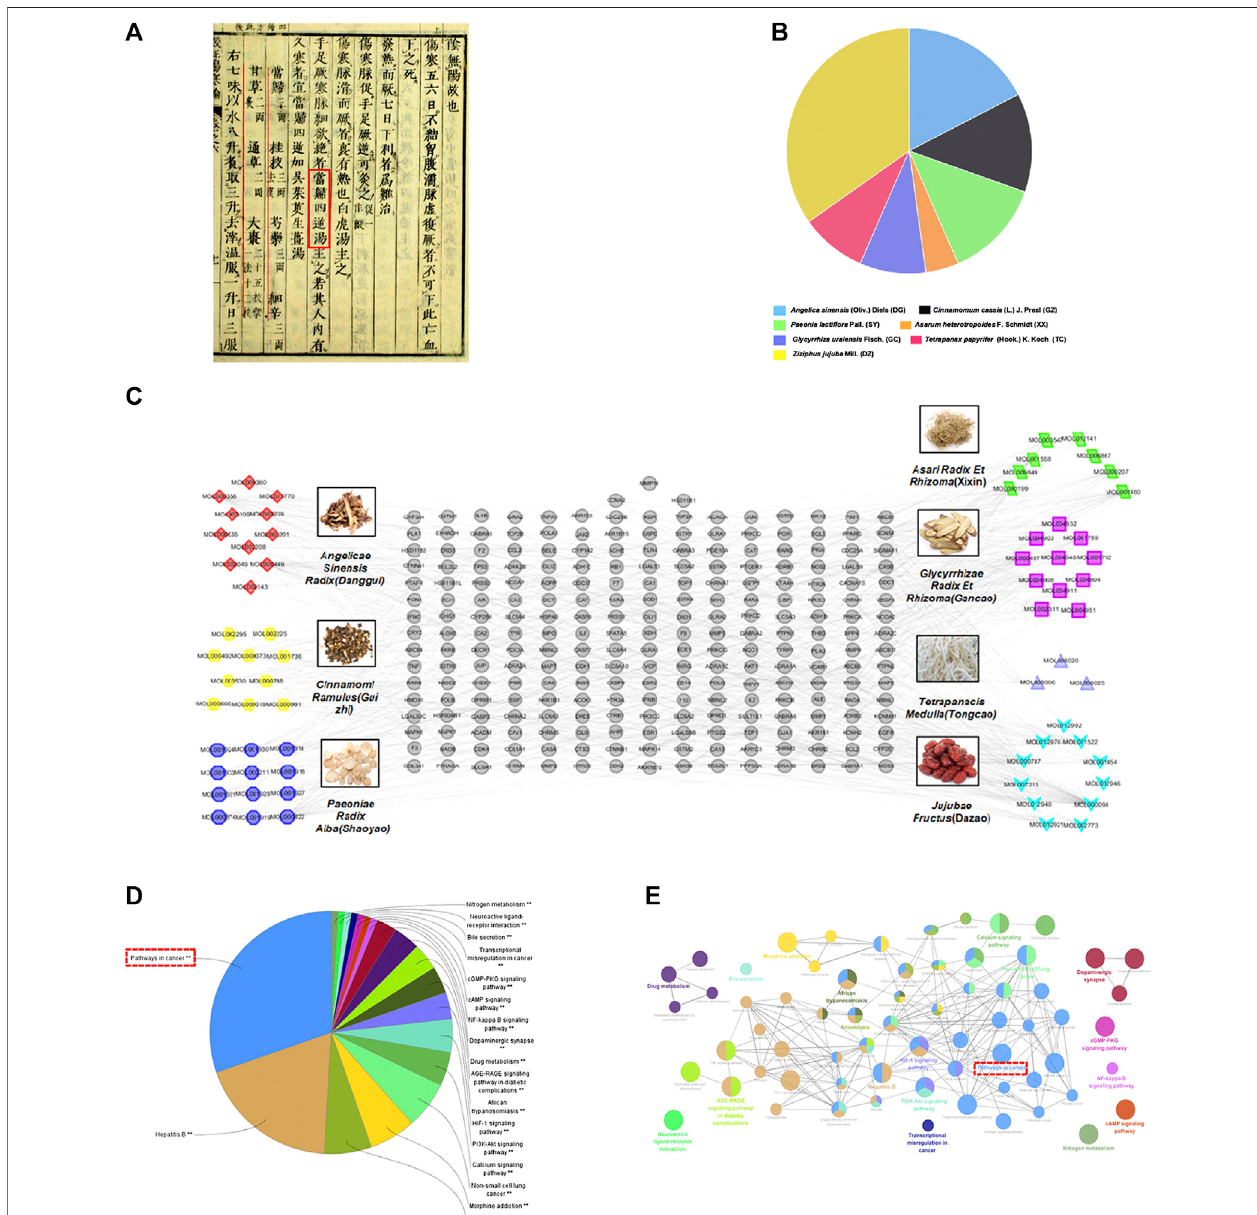
FIGURE1| ConstructionoftheDSDcandidateactiveingredient-putativetargetnetworkandenrichmentanalysis. (A) DangguiSiniDecoction(DSD)obtainedfrom theTreatiseonFebrileDiseases(Han Dynastyinancient China). (B) Thequalitymatchingofsevenimportantpharmaceuticalingredients fromDSD(DG,GZ,SY,XX,GC, TC, and DZ). (C) This complex and systematic network was constructed by linking the candidate active ingredients and their putative targets of the seven herbs, which were constituents of DSD. (D,E) Putativedrug targets were enriched in the representative signaling pathways using ClueGO plugin ( p < 0.05).